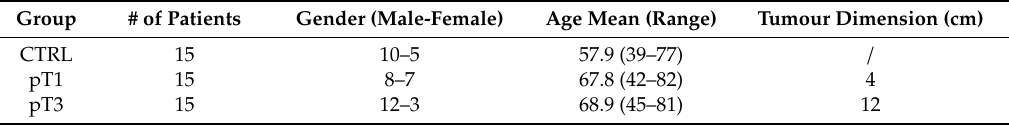
Table 1. Clinicopathological data regarding the patients enrolled in the